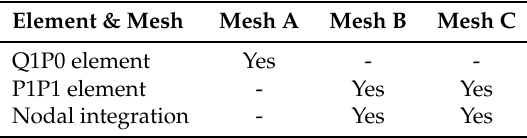
Table 2. Meshes and elements used.